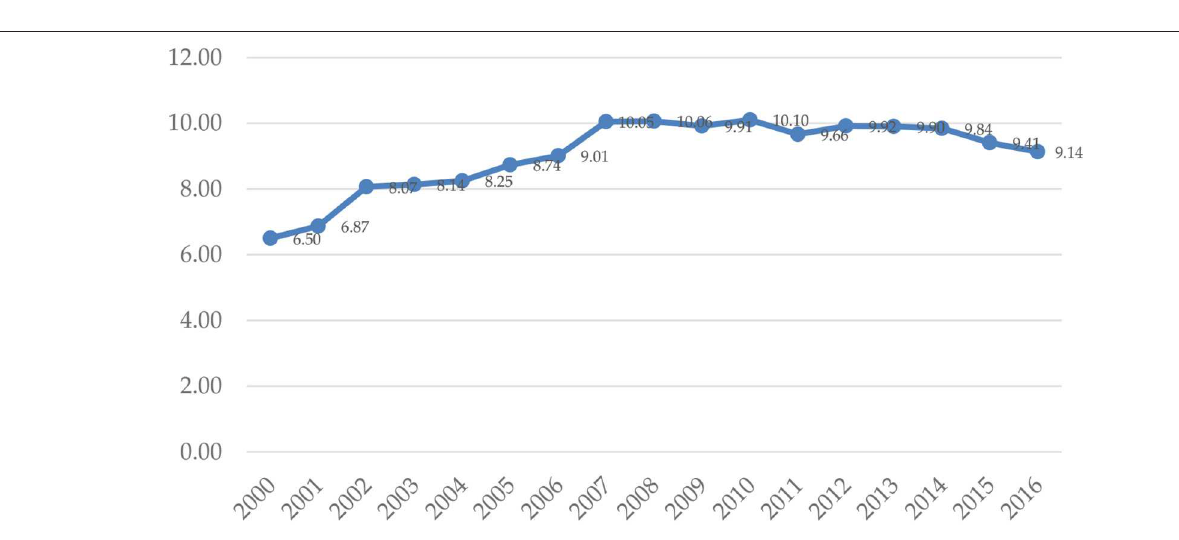
FIGURE 2 | Current health expenditure as a percentage of GDP in Serbia in 2000–2016. Source: WHO Global Health Expenditure